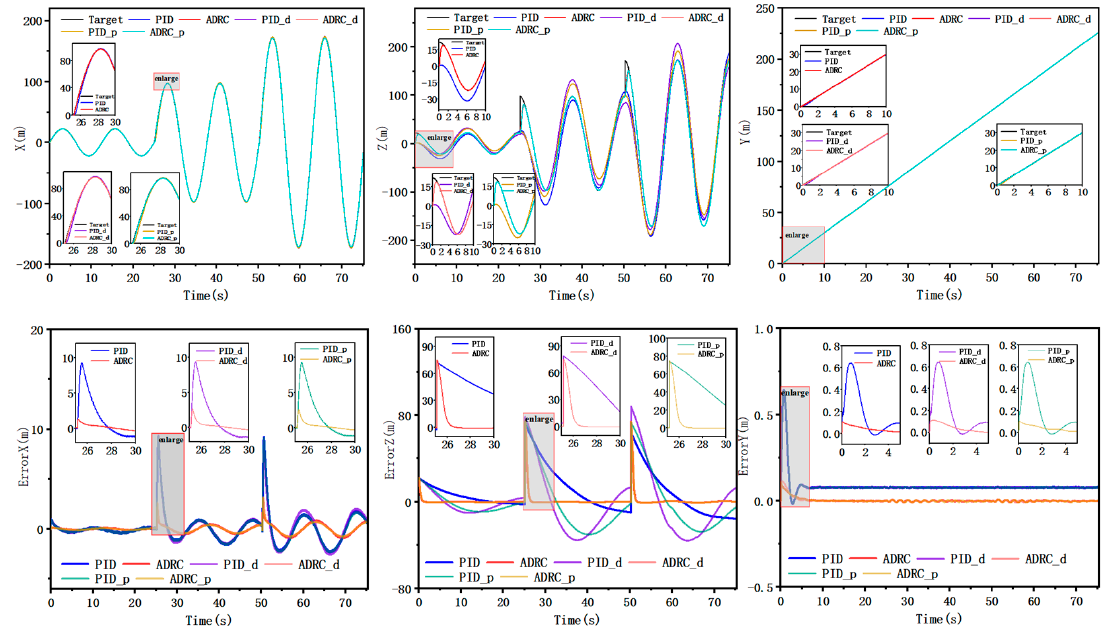
Figure 14. Three-axis trajectory tracking response and error.